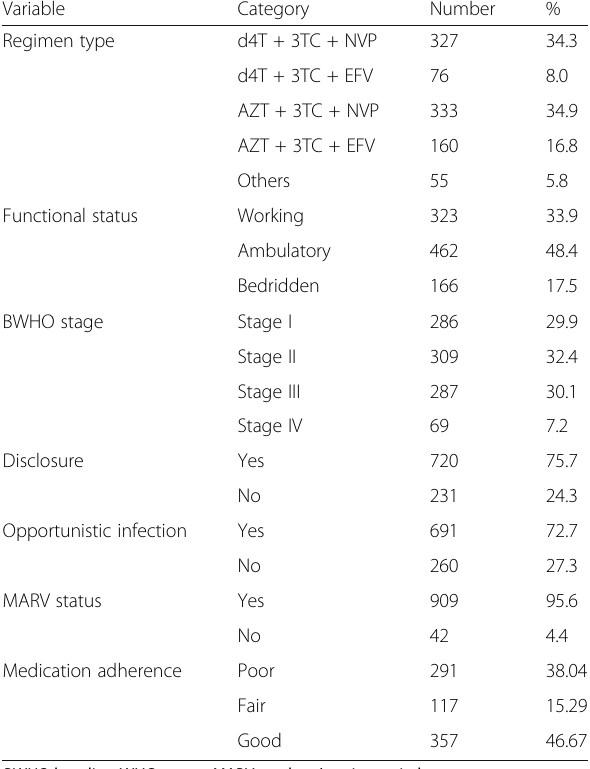
structure offered the smallest information criterion and selected a random effect parameter model (Table S1 and S2). The values obtained from the study of the average logCD4 count of children at baseline were therefore 2.76, excluding covariate effects. The multivariable linear mixed model found covariates such as age, opportunistic infections, baseline WHO clinical stage II, and baseline hemoglobin levels were significantly correlated with